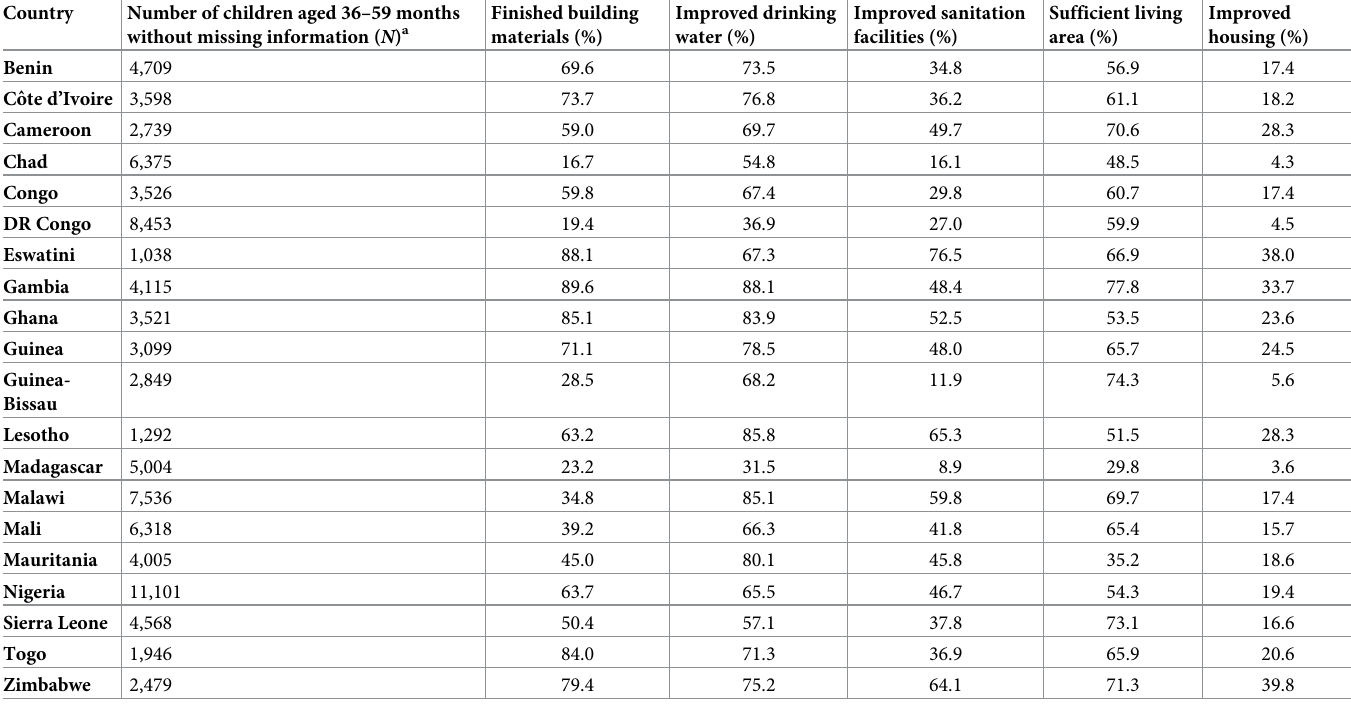
Table 3. Characteristics of housing qualities of study participants. Country Number of children aged 36–59 months without missing information ( N ) a